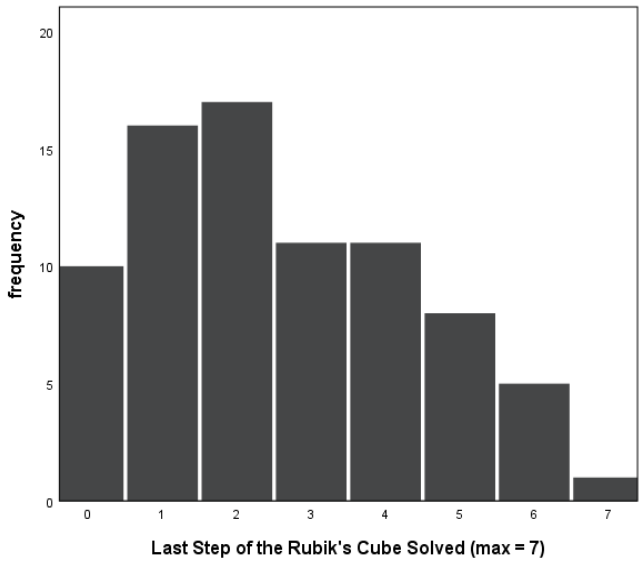
Figure 1. Histogram illustrating number of participants reaching each step.